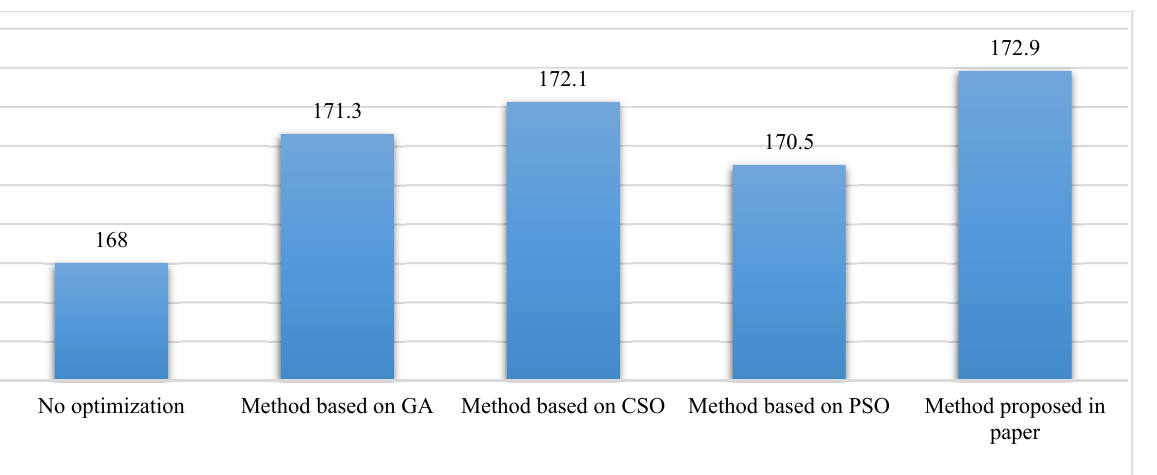
Figure 7. Comparison of run time of different methods.